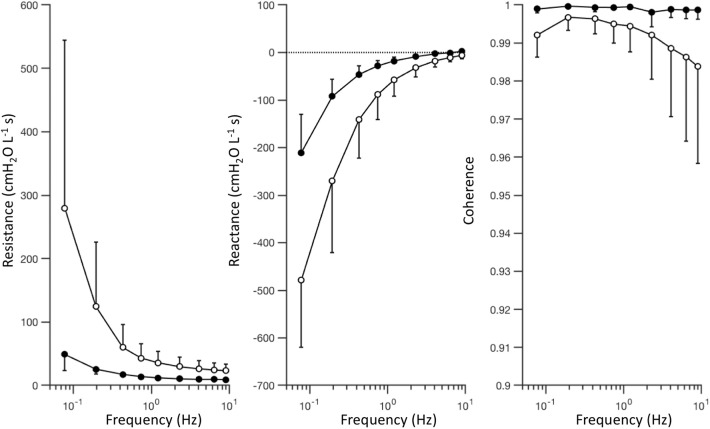
Respiratory impedance measured under baseline (black) and injured (white) conditions, represented by the mean value (circles) and standard deviation (error bars) at each frequency, across subjects. The complex-valued impedance spectrum is represented by its real part or in-phase component (i.e., resistance), and its imaginary part or out-of-phase component (i.e., reactance). Coherence provides an estimate of signal quality and linearity of the measured relationship between pressure and flow oscillations.